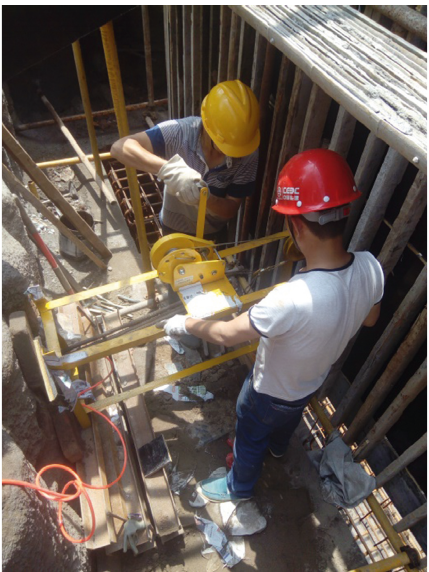
Figure 14: Field recycling of the inflatable recyclable anchor.